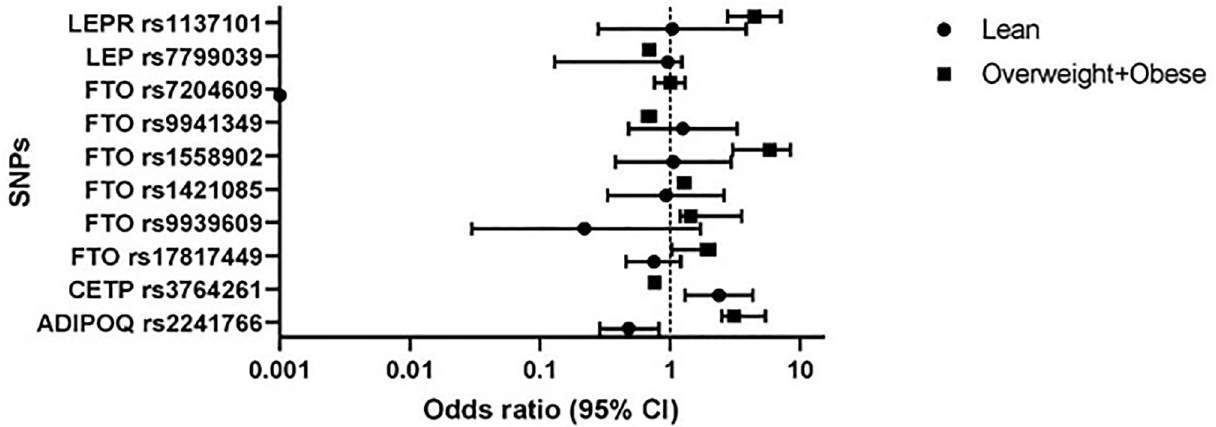
Fig 2. Association analysis of minor alleles with BMI stratified categories. Associations of genetic variants with BMI based categories (Lean and Over- weight + Obese) were obtained by Odds ratios (ORs) with 95% confidence intervals (95% CI). ORs (95% CI) were calculated using age and gender adjusted logistic regression models and normal BMI category considered as reference group with an OR = 1.0.